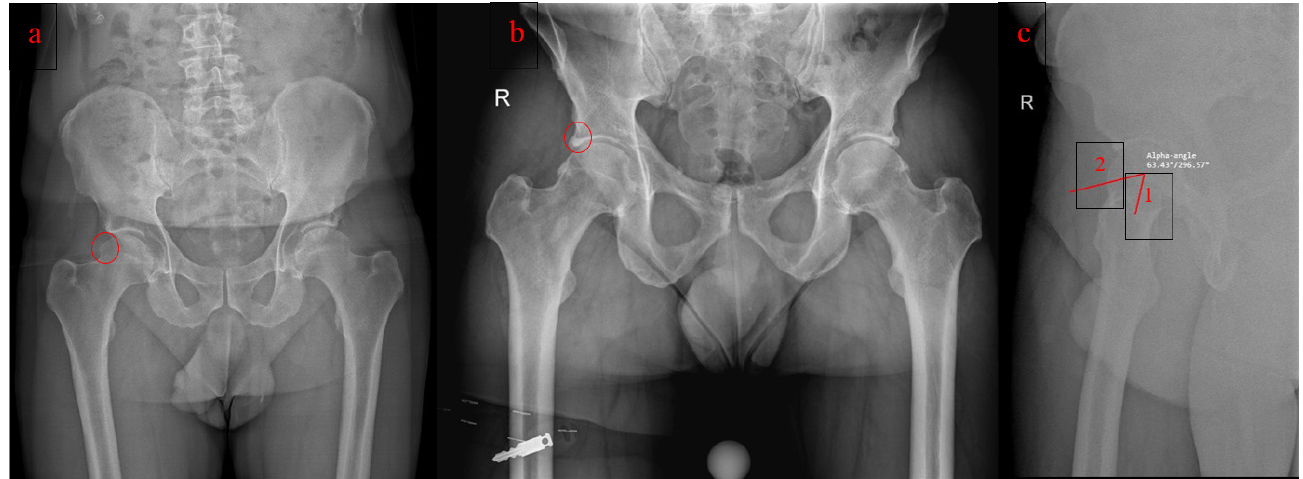
Figure 1. ( a ). FAI Cam type ( b ). FAI Pincer type ( c ). α angle in a lateral view: line 1 passing from the center of the femoral head to the center of the femoral neck and line 2 passing from the center of the femoral head to a point where the distance from the bone to the center of the head is greater than the radius of the cartilage covered femoral head.